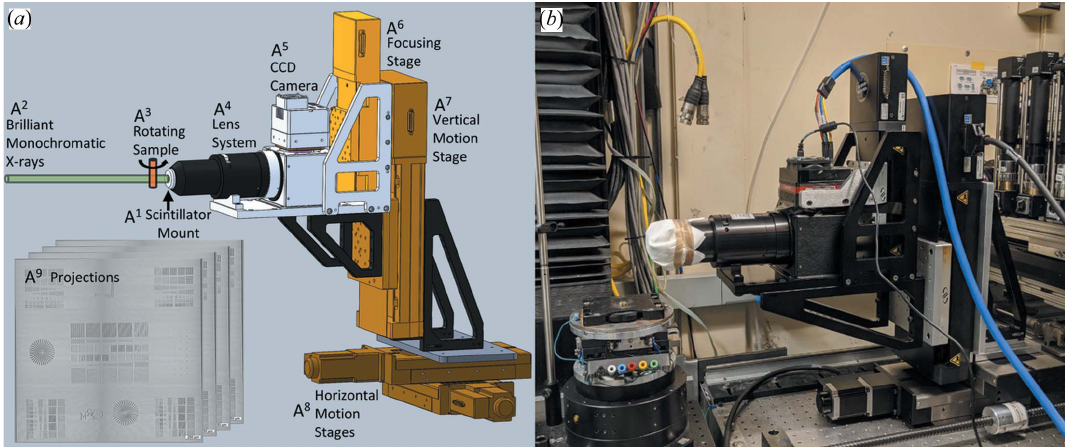
Figure 1 Generalized beam alignment and image acquisition setup for application in synchrotron facilities and tabletop sources. CAD design ( a ). Actual setup as assembled in the Berkeley ALS 8.3.2 beamline hutch ( b ). Our custom detector operates using a scintillator (A 1 ) to convert X-rays (A 2 ) passing through a sample (A 3 ) into visible light. The fluorescence image is then focused by the objective lens (A 4 ) onto the CMOS sensor surface (A 5 ). Commercially available Newport stages (A 6 –A 8 ) were utilized to adjust the camera relative to the focal point, and to translate the detector through three-dimensional space (15 cm vertical travel and 10 cm horizontal travel in any direction) for optimal alignment with any synchrotron- or tabletop-generated beam. Projections (A 9 ) acquired by the detector are saved using the Harvester Python library and later reconstructed with the TomoPy toolbox in